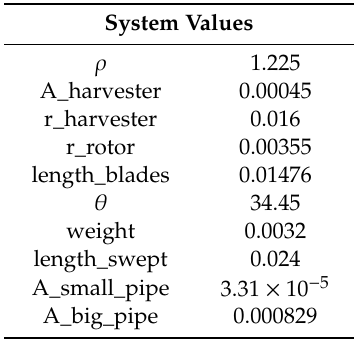
Table 1. Micro-reactor dimensional-mechanic